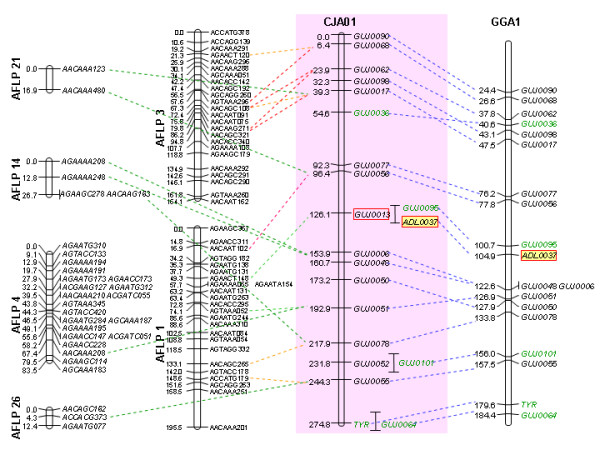
Alignments of Japanese quail microsatellite and AFLP maps and links to the assembled chicken sequence. Left: AFLP linkage groups from [14]; center: integrated microsatellite and gene map (this study); right: chicken February 2004 sequence assembly [22]. AFLP and microsatellite genetic maps are in cM and the sequence assembly is in Mb. New quail linkage groups have blue titles and new microsatellite and gene markers are in green. Genes are in boldface italic. Microsatellite markers informative in both species are in red boxes. Chicken markers have a yellow background. Quail microsatellites or genes with similarity to chicken sequence of unknown location (chrun) have a blue background. Dotted lines linking the microsatellite and the AFLP maps indicate positive results of two-point linkage between the markers, with supporting LOD scores of 3 to 6 (green), 6 to 10 (orange) or more than 10 (red).